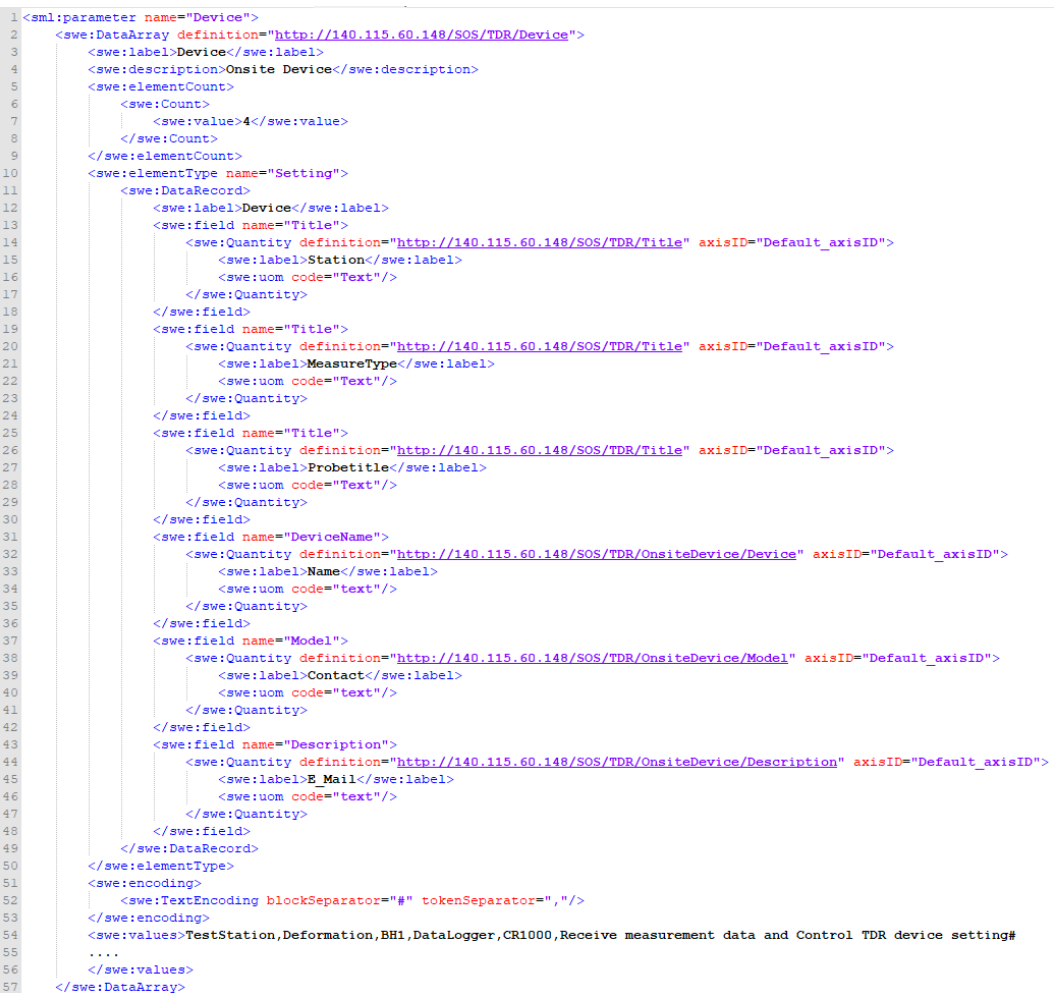
Figure 11. Extended InsertSensor format for InsertSensor_Device